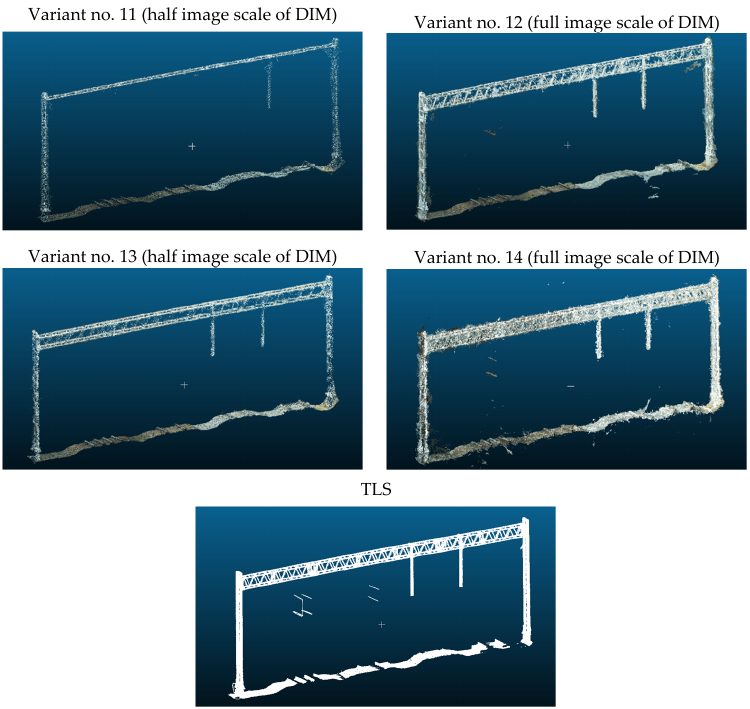
Figure 1. Point cloud fragments clipped to the gate object for all analyzed variants. When comparing even the most accurate point cloud variants from dense image matching with terrestrial laser scanning data, it is apparent that some elements have not mapped into the dense point cloud. Furthermore, as more details are mapped and the density of the point cloud increases, noise increases. Such an effect is not desirable, especially when the next step is to project the points into pixel coordinates of the image to determine each object’s precise location (bounding box).